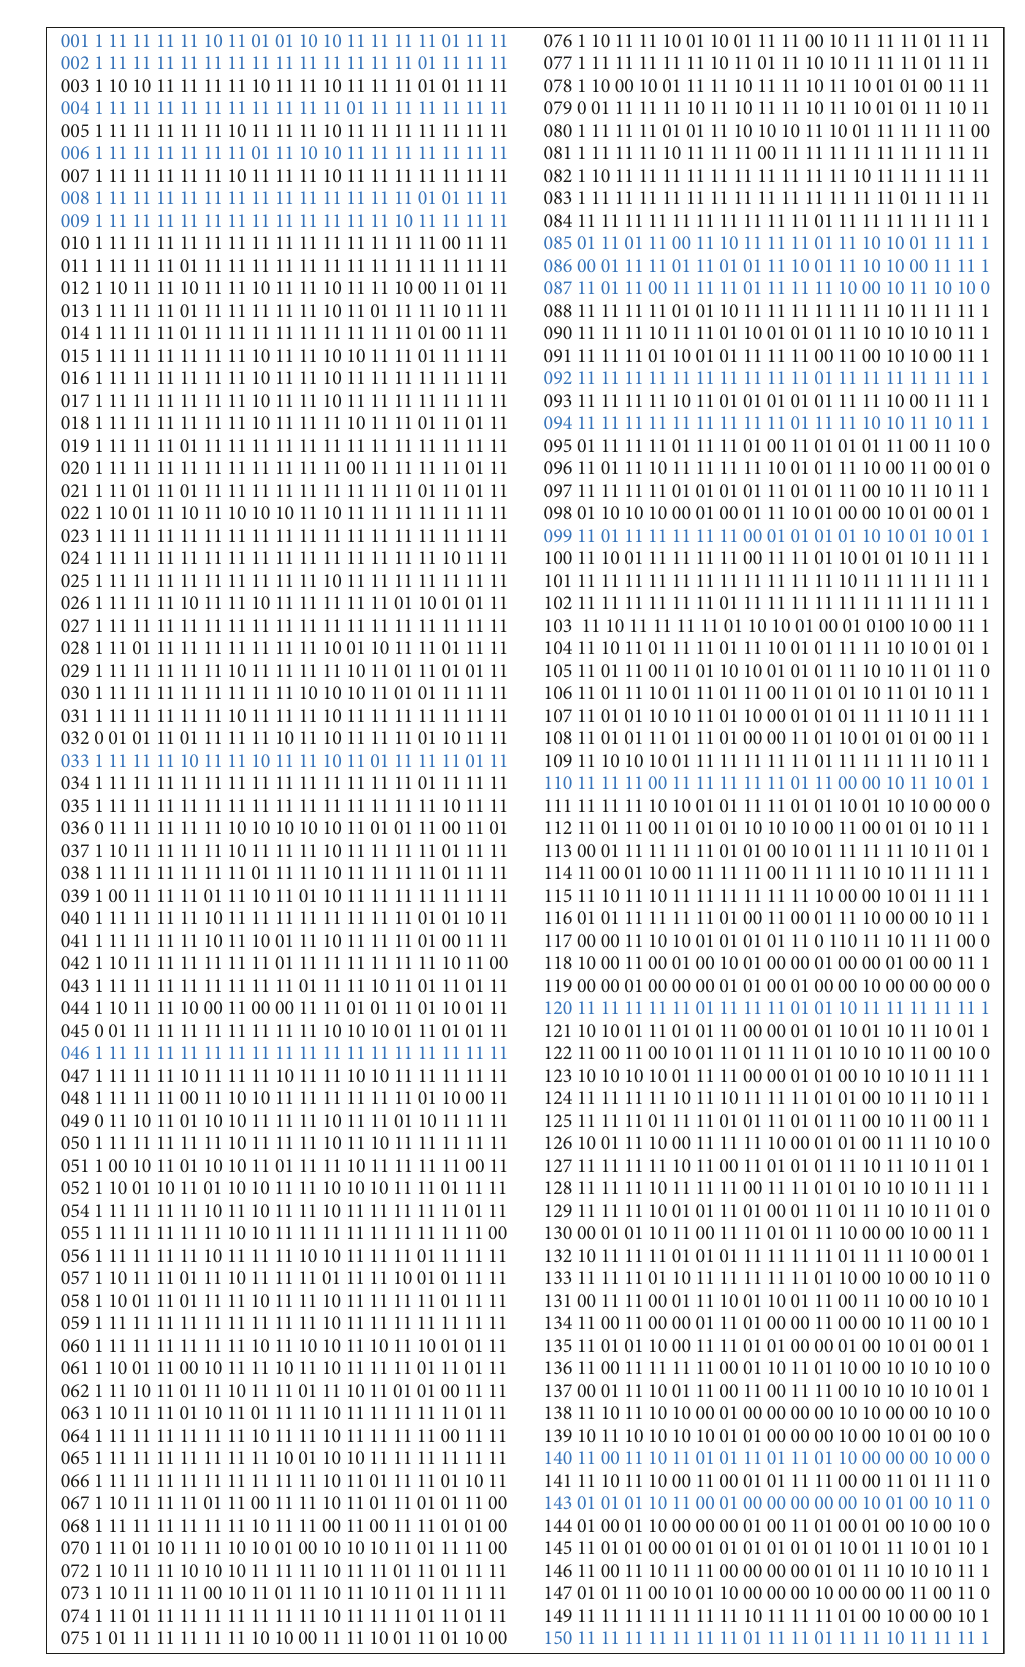
Figure 4: Guttman